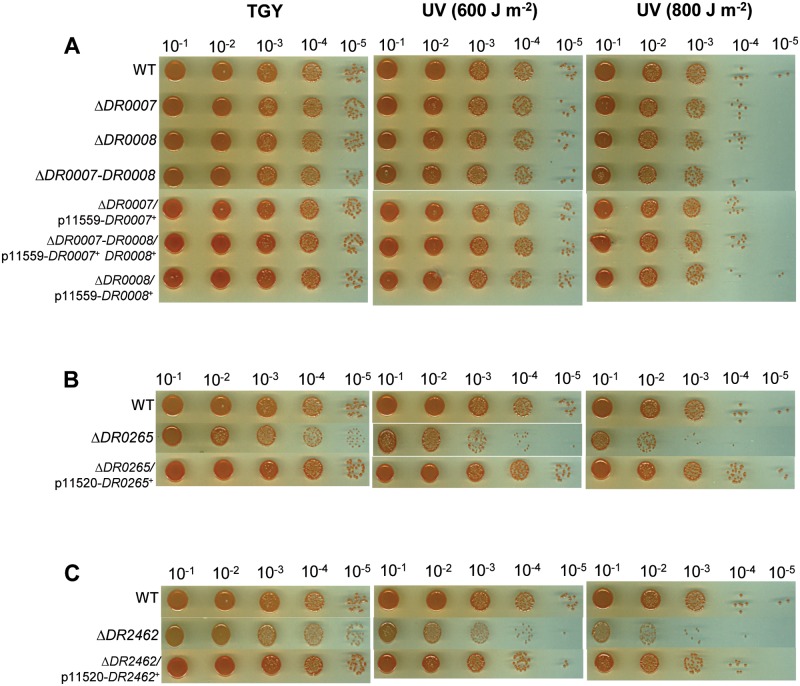
ΔDR0265 and ΔDR2462 are sensitive to UV but not ΔDR0007 and ΔDR0008.Bacteria were grown in TGY2X liquid medium to A650 = 1, serially diluted and dilutions were spotted onto TGY agar plates subsequently exposed to UV-irradiation at the indicated doses.